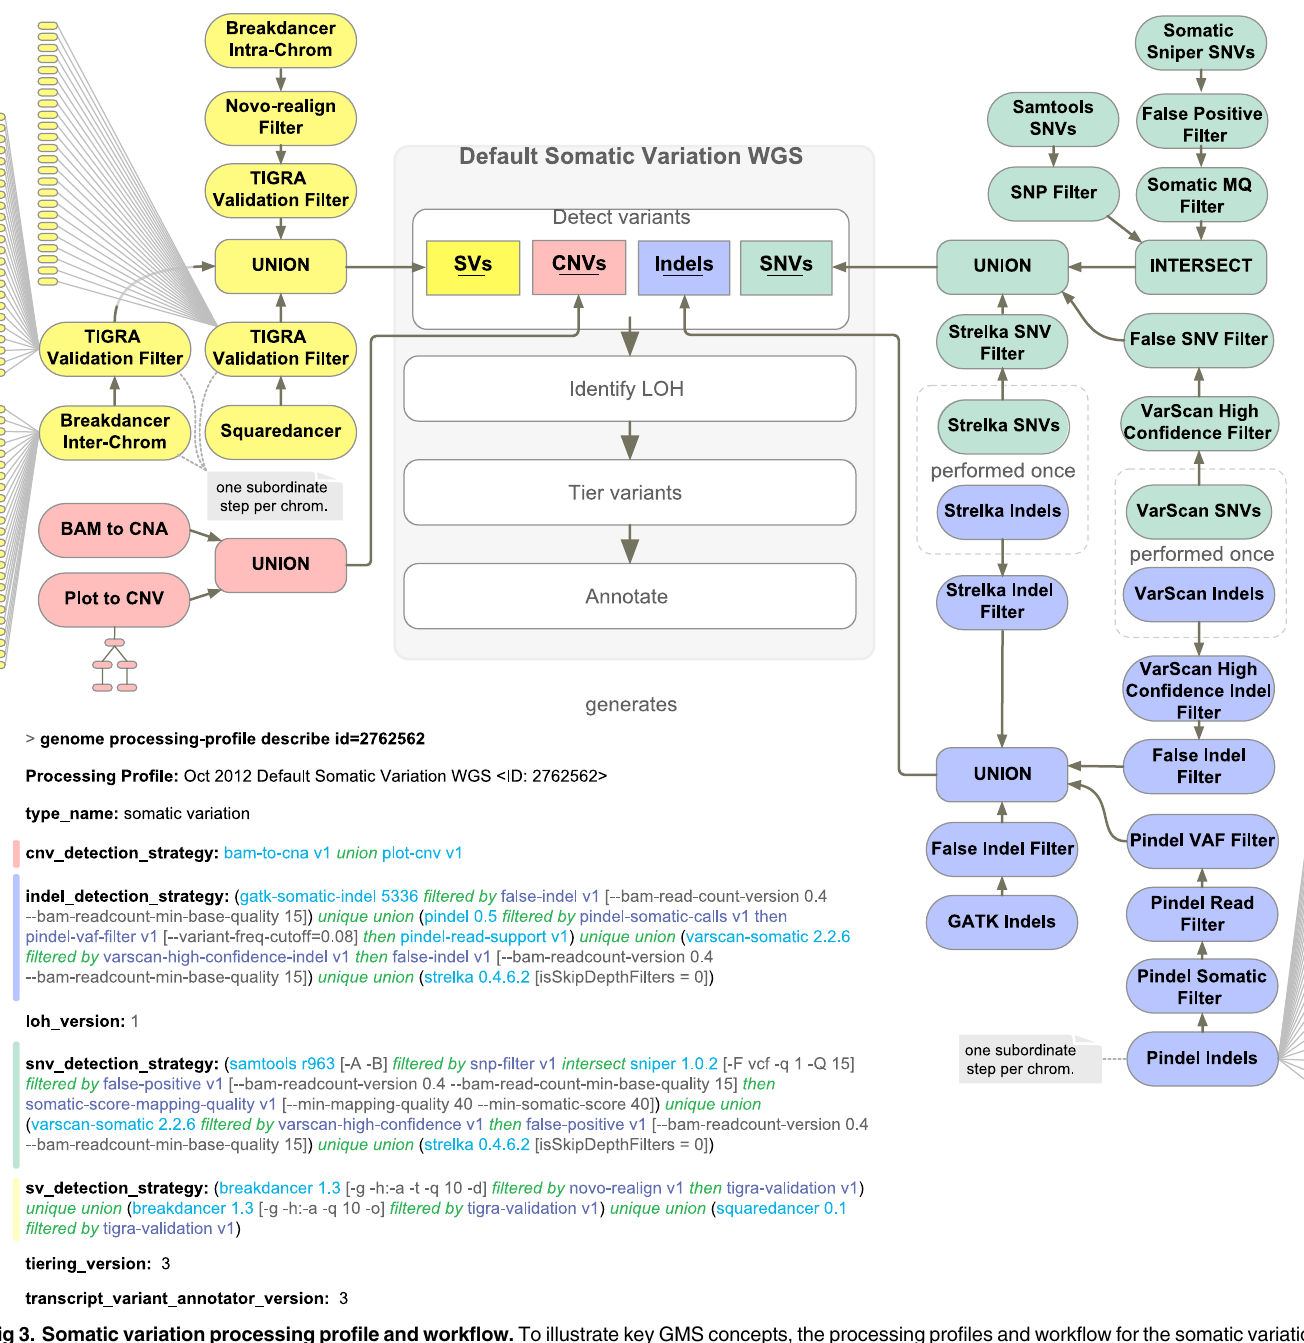
Fig 3. Somatic variation processing profile and workflow. To illustrate key GMS concepts, the processing profiles and workflow for the somatic variation pipeline are shown. Abbreviations: copy number variant (CNV), copy number amplification (CNA), genome analysis tool kit (GATK), insertion/deletion (Indel), loss of heterozygosity (LOH), mapping quality (MQ), single nucleotide variant (SNV), structural variant (SV), variant allele frequency (VAF).